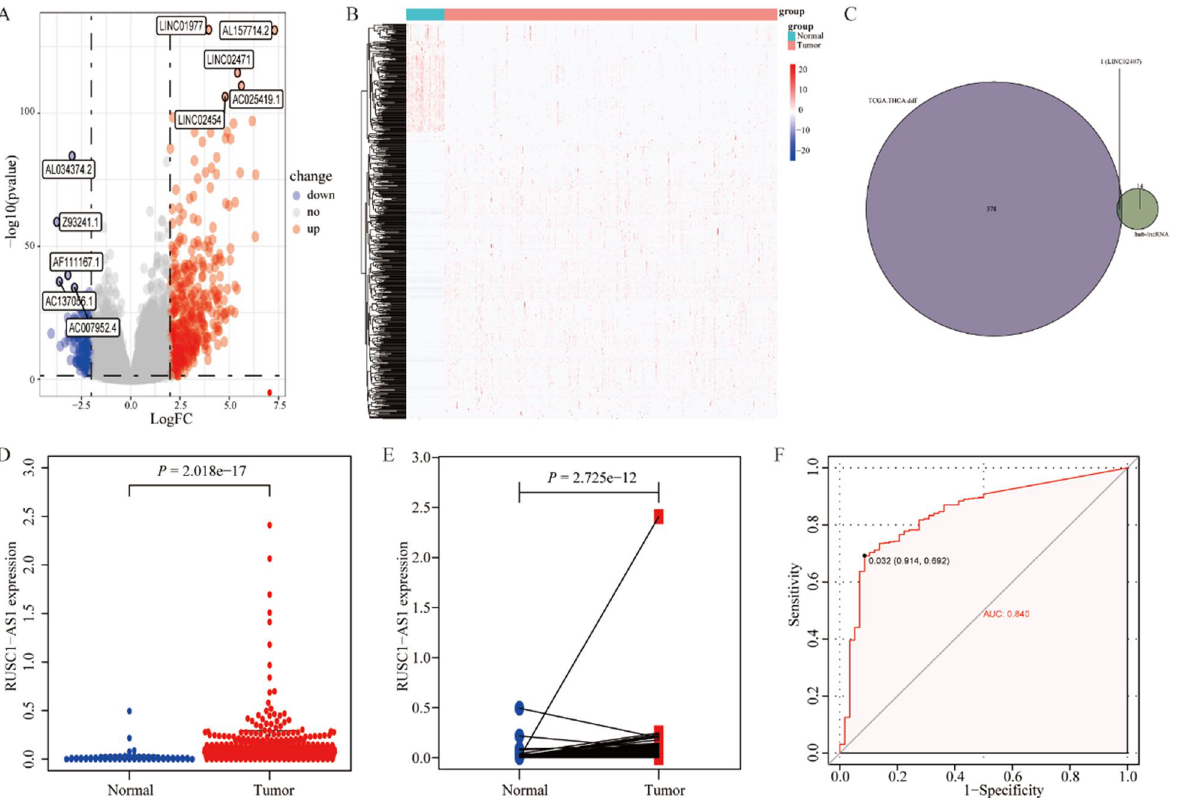
Figure 7. Analysis of differentially expressed lncRNA in tissues from patients with THCA in TCGA database. ( A ) Volcano plots and ( B ) heatmaps showing differentially expressed lncRNAs between THCA cancer and cancer-adjacent tissues in TCGA database. ( C ) Venn diagram showing the intersection between significantly differentially expressed lncRNAs and key lncRNAs. ( D, E ) Comparison of the levels of expression of LINC02407 ( D ) between tumor tumor-adjacent tissues and ( E ) between tumor and paired paracancerous tissues of the patients with THCA. ( F ) ROC curve analysis shows that LINC02407 enabled good discrimination between cancer and cancer-adjacent tissues of patients with